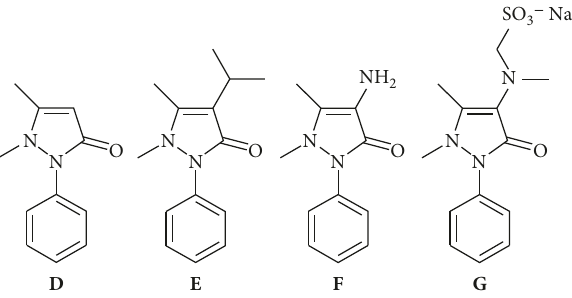
Figure 1: Structures of ( D ) phenazone, ( E ) propyphenazone, ( F ) ampyrone, and ( G )